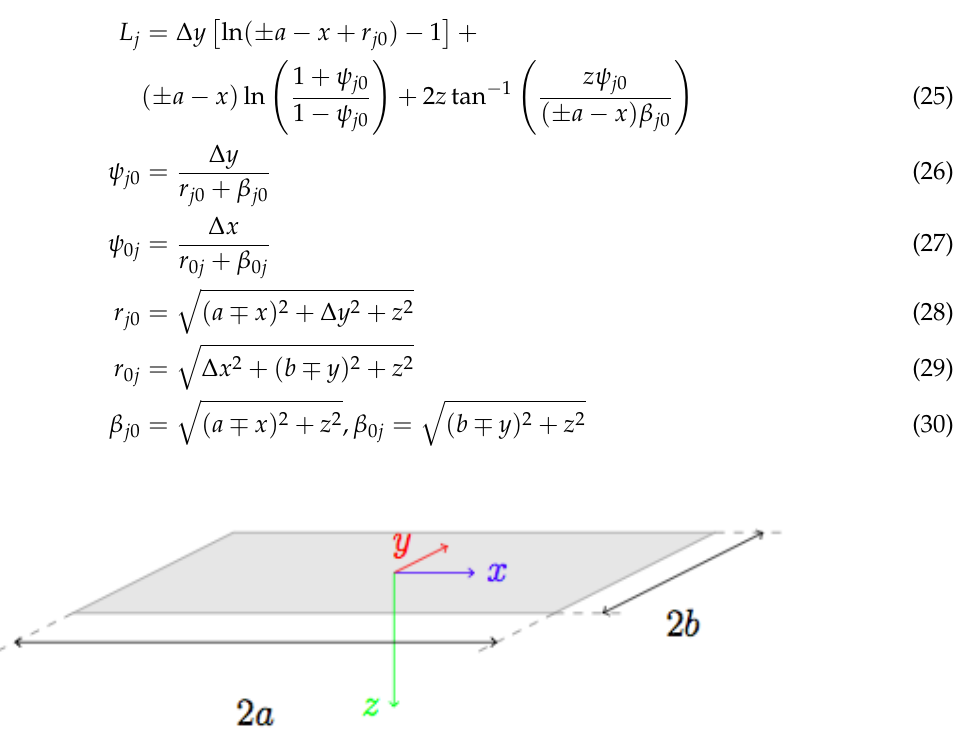
Figure 4. Love’s solution assumes rectangular pressure cells at the surface of an elastic